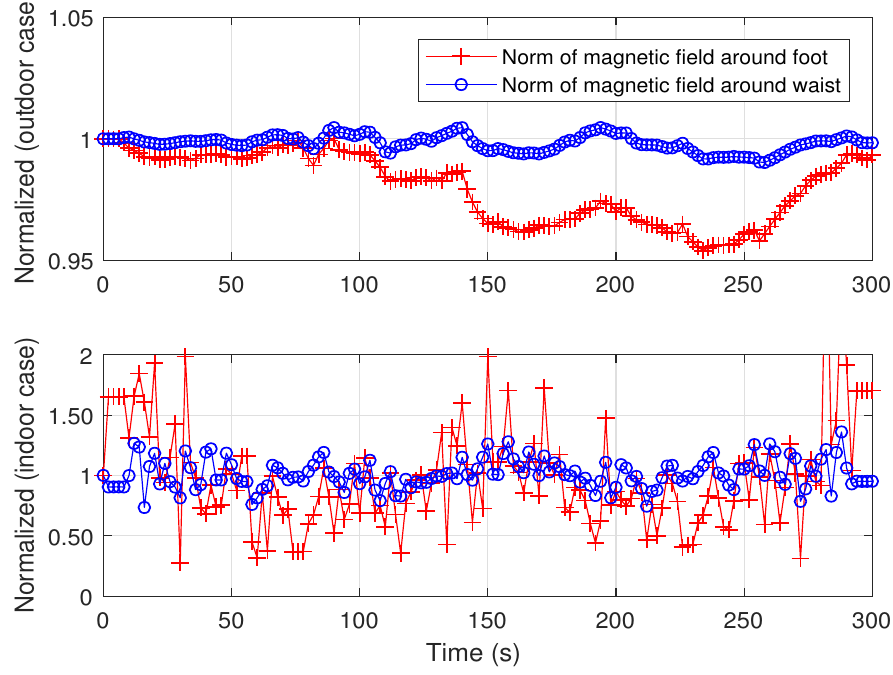
Figure 3. Normalized magnetic norm around foot (red line with ‘+’ markers) and waist (blue line with ‘o’